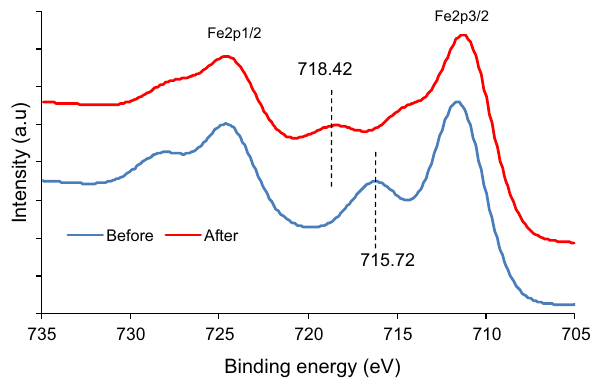
Fig. 12 XPS spectra of AC@Fe/3 catalyst before and after the degra- dation of Rhodamine B